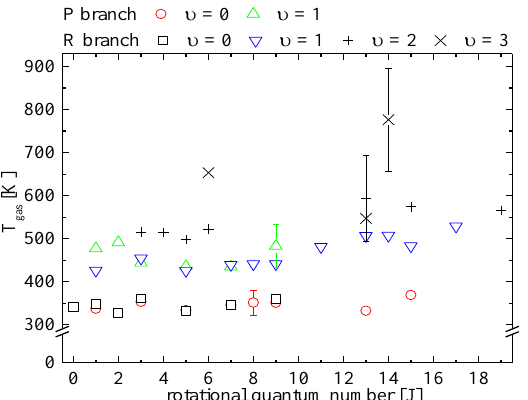
Figure 36. Gas temperature T gas determined from the Doppler broadening of CO lines as a function of their rotational quantum number for the R and P branches for the ground and the first, second and third excited vibrational levels, p = 0.25 mbar, P = 3 kW, φ = 50 sccm, CH 4 admixture: 2.5%, CO 2 admixture: 1% [66], © IOP Publishing. Reproduced with permission. All rights reserved.